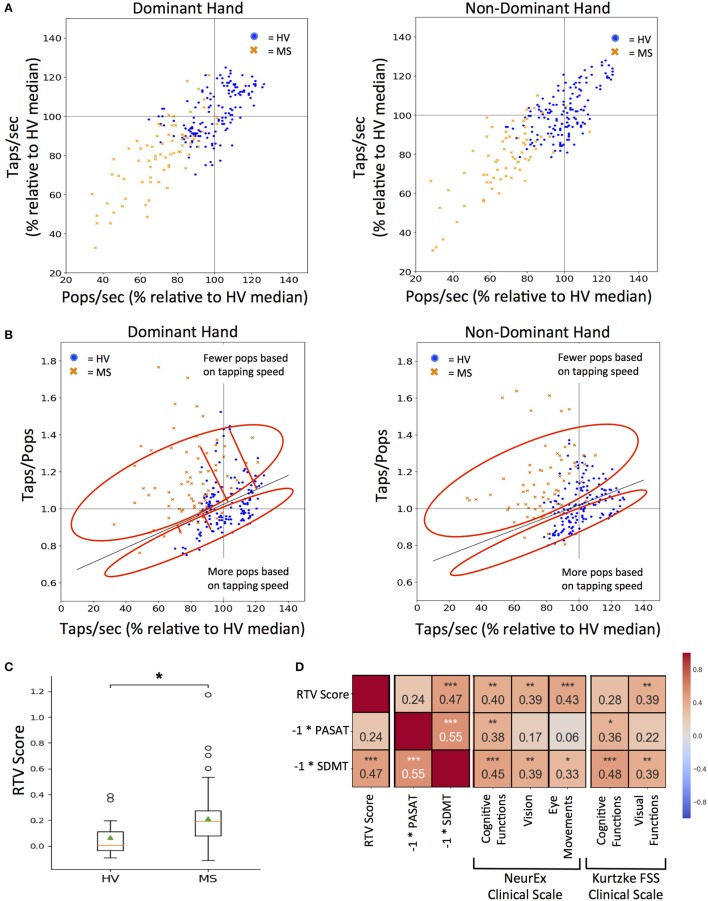
RTV: Response Time and Visual dysfunction score. (A) Tapping and popping scores directly compared for each test participant (blue dots for HV and orange dots for MS) on the first test sitting. 100% mark (gray lines) for both scores was derived from the median of all HV data for tapping and popping respectively. (B) Comparing each participant's taps/pops versus taps/sec to calculate RTV score, which is the orthogonal residual to the best-fit line (dark gray line) derived from HV data (cross sectional and longitudinal). The red circle vertically above the HV best fit line represents positive residuals which correspond to tests where the user had fewer pops based on their tapping speed as compared to HVs and vice versa for the red circle vertically below the HV best fit line. Red lines extending from the HV best-fit line indicate the orthogonal residual examples that are used as RTV scores. (C) Distribution of RTV scores between HV and MS cohorts after each participant's cross-sectional dominant and non-dominant scores were averaged. On each box plot, green triangles indicate the mean and orange lines indicate the median of depicted cohort datasets. Box plot box boundaries represent the Q1 to Q3 range centered about the median. Box plot whisker lengths extend to Q1–1.5 *IQR and Q3 + 1.5 *IQR. (D) Pearson correlations between RTV scores and corresponding clinical tests and clinical scale score for cognitive and visual function. Red to blue heat map represents value of the correlation coefficient ranging from 1 to −1, respectively. *p < 0.01, **p < 0.001, ***p < 0.0001.